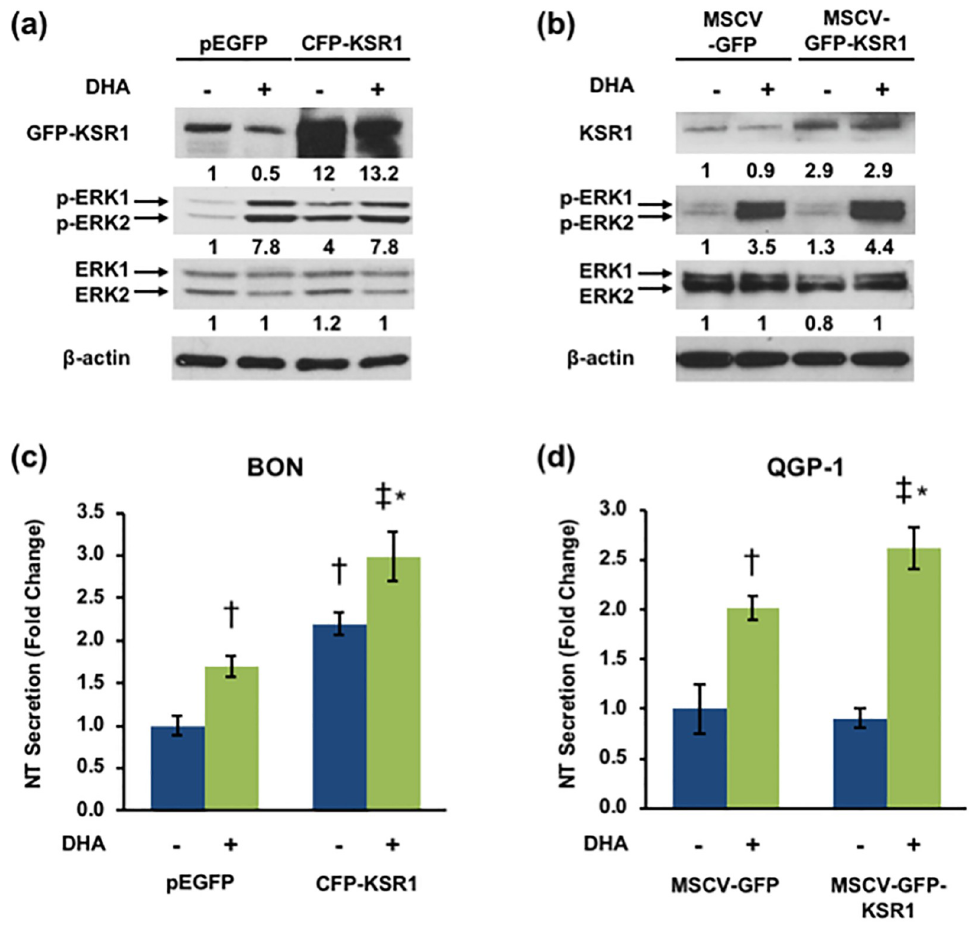
Fig 4. Overexpression of KSR1 enhances NT secretion and ERK activation. (a) BON cells were transfected with pEGFP-control and pECFP-N-KSR1 plasmid DNA and QGP-1 cells were transfected with MSCV-IRES-GFP and MSCV-KSR1-IRES-GFP plasmid DNA (b) and treated with or without 100 μ M DHA for 90 min. Cells were lysed and western blotting analysis performed. Band intensity is indicated below the corresponding band and expressed as fold- change relative to NTC. Each blot is representative of two independent experiments. (c) BON cells were transfected with pEGFP-control and pECFP-N-KSR1 plasmid DNA and QGP-1 cells were transfected with MSCV-IRES-GFP and MSCV-KSR1-IRES-GFP plasmid DNA (d) and treated with or without 100 μ M DHA for 90 min. Media were collected and NT-EIA performed. Panel (c): †p < 0.05 vs. untreated pEGFP; � p < 0.05 vs. pEGFP plus DHA; ‡p < 0.05 vs. untreated CFP-KSR1; Panel (d): †p < 0.05 vs. untreated MSCV-GFP; � p < 0.05 vs. MSCV-GFP plus DHA; ‡p < 0.05 vs. untreated MSCV-GFP-KSR1. Data represent mean +/- SD and are representative of three independent experiments.